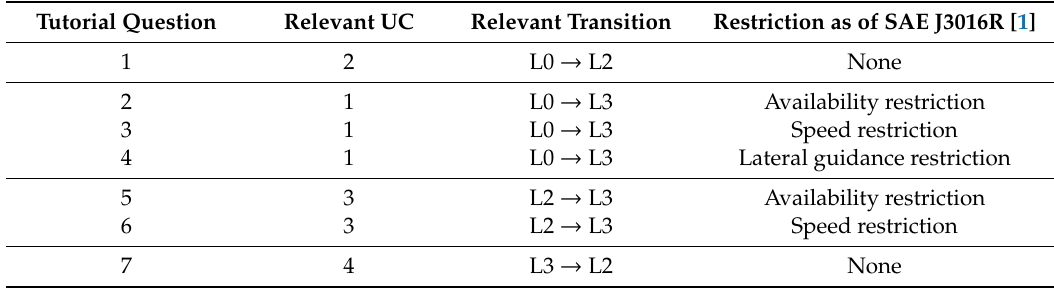
Table 4. Overview of tutorial questions with corresponding UC, transition, and type of restriction for the